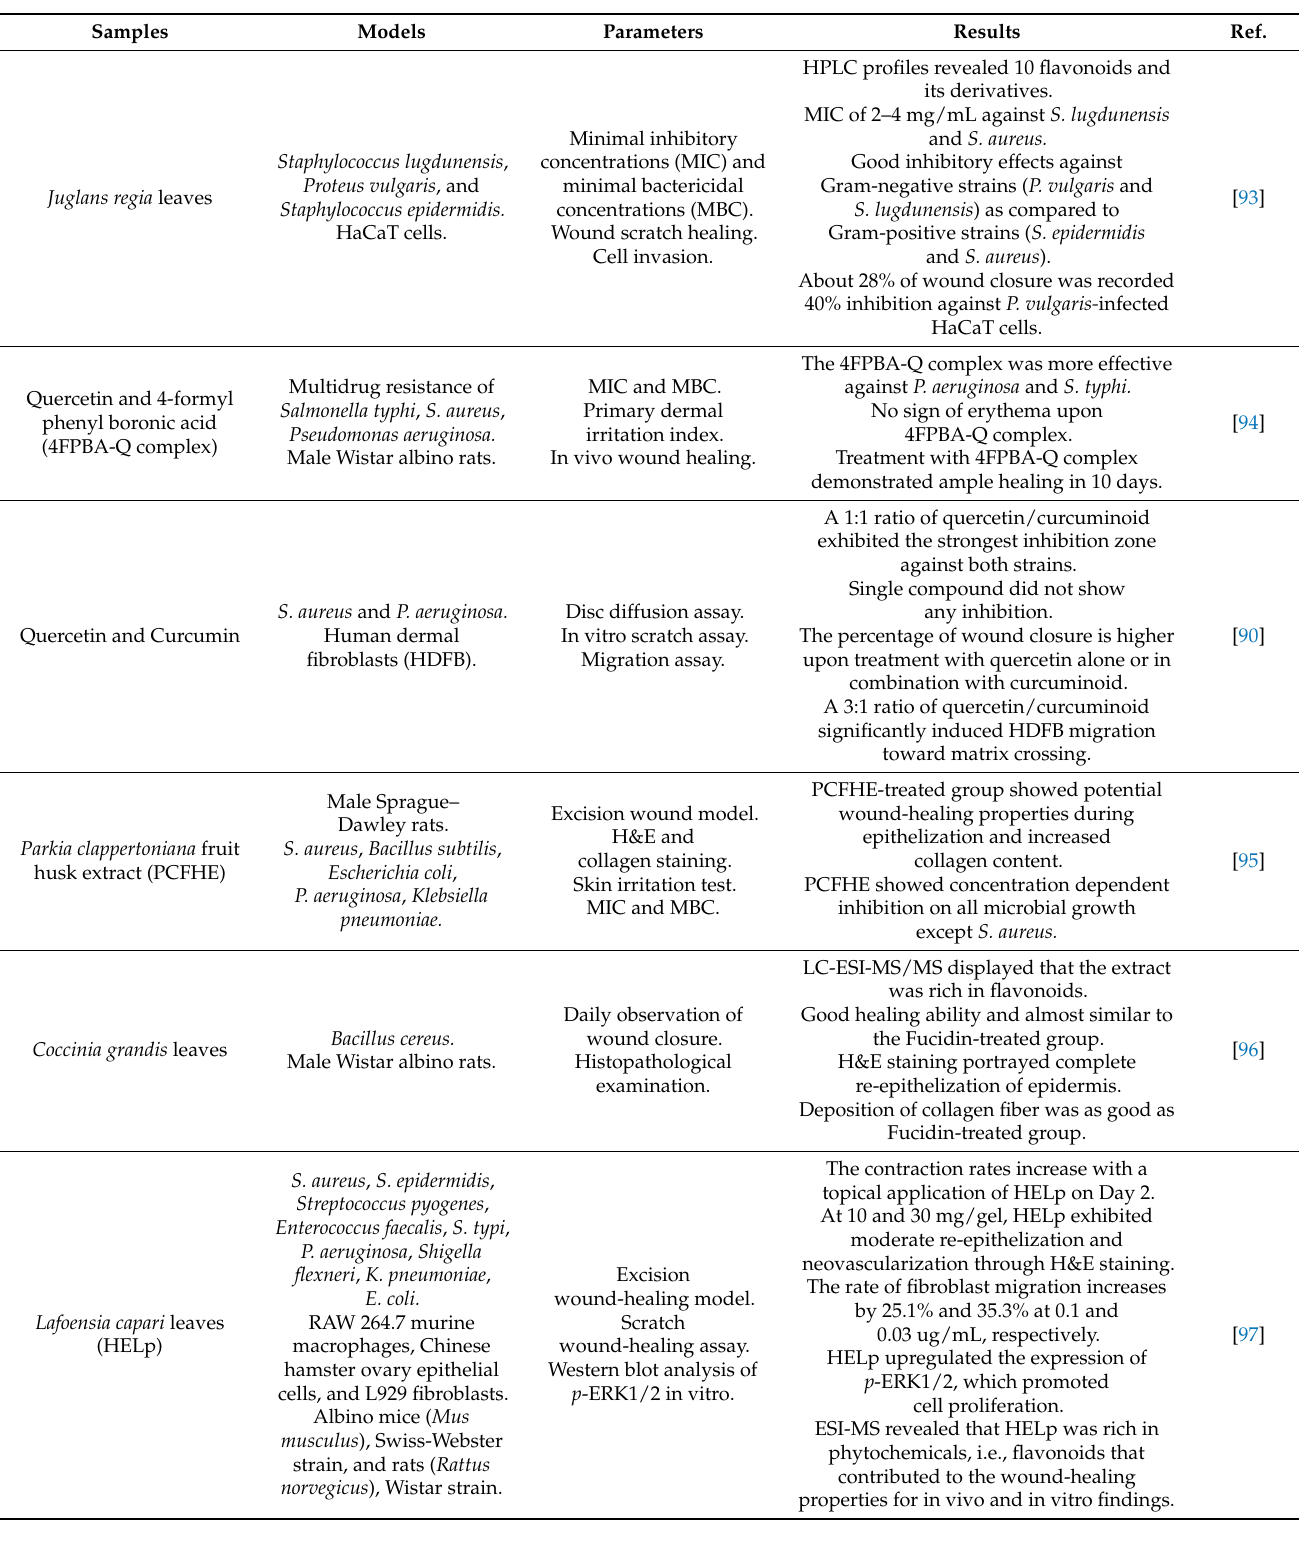
Table 3. The application of flavonoids as anti-bacterial agents on wound